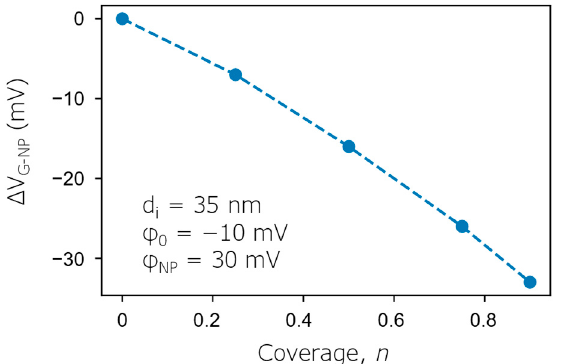
Figure 3. Calculated ConCap signal change ( Δ V G-NP ) of an AuNP-decorated EISCAP as a function of the AuNP coverage with n varying from 0.25 to